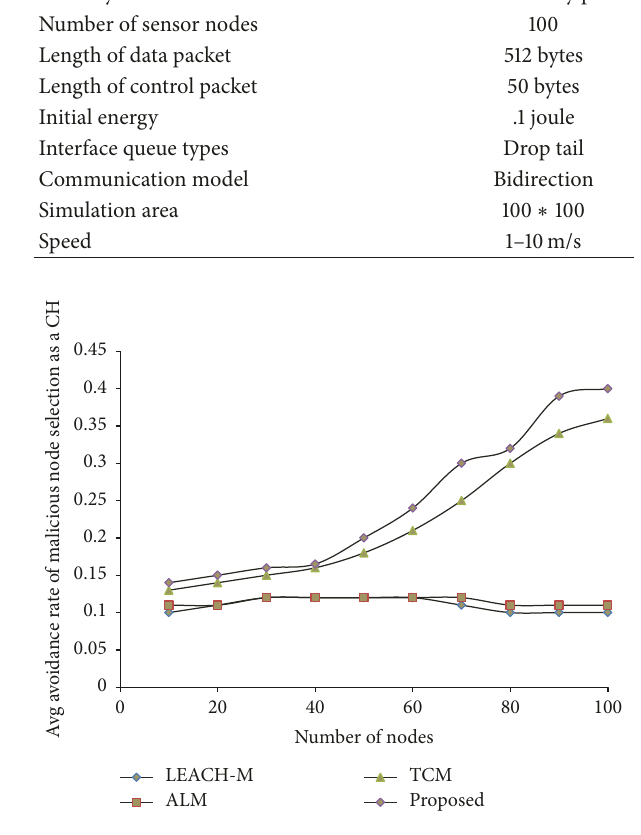
Figure 1: Average avoidance rate of malicious node selection as a CH versus number of